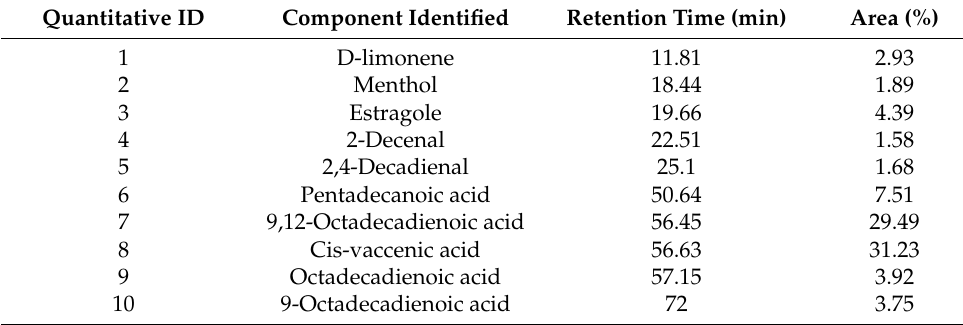
Table 2. Chemical composition of Foeniculum vulgare oil by GC-MS analysis.